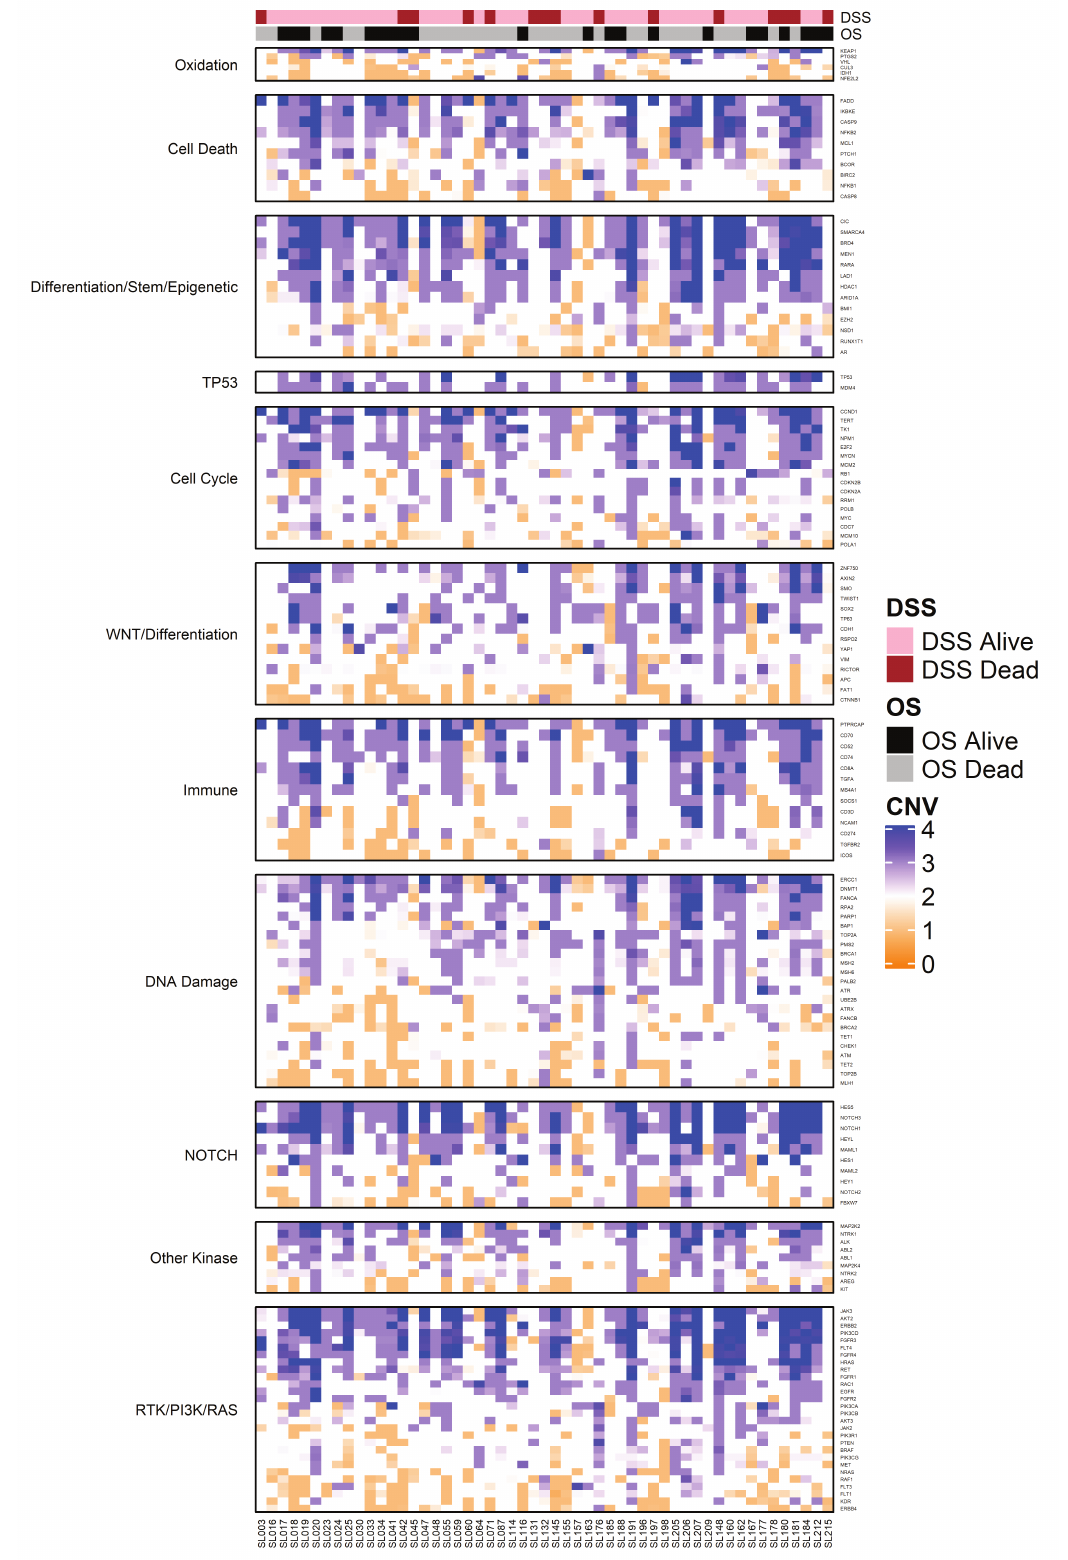
Figure 1. Copy Number Variation (CNV) Analysis. Heat map illustrating unsupervised clustering of CNV analysis grouped by pathway. Disease and Overall Survival status depicted across the